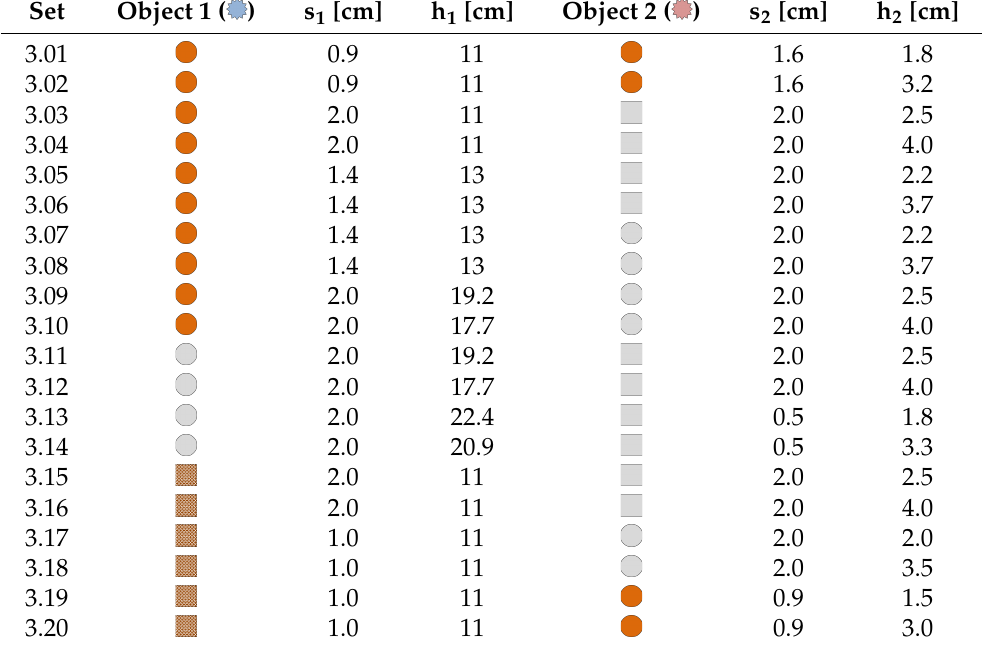
Figure 7. Scenario 3: two objects of different size, shape and material. ( a ) Picture of an acquisition and ( b ) its sketch in a two-dimensional plane. Table 4. Scenario 3: two objects of different size, shape and material (Figure 7). The quantity s refers to the diameter for spherical objects and to the side for